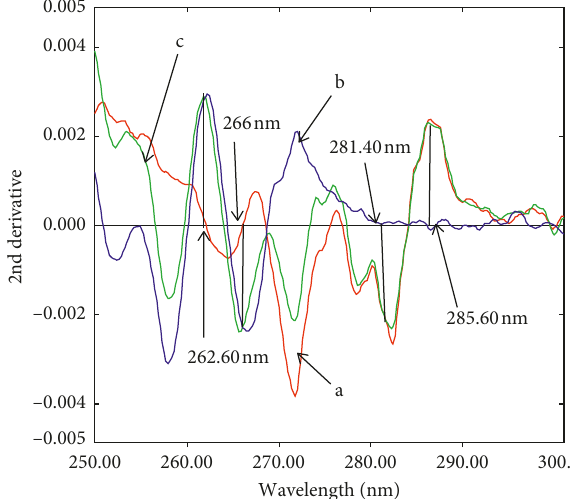
Figure 3: First-order derivative spectra of (a) 10.0 μ g · mL − 1 of pyriproxyfen, (b) 3.0 μ g · mL − 1 of chlorothalonil, and (c) their mixture in methanol.